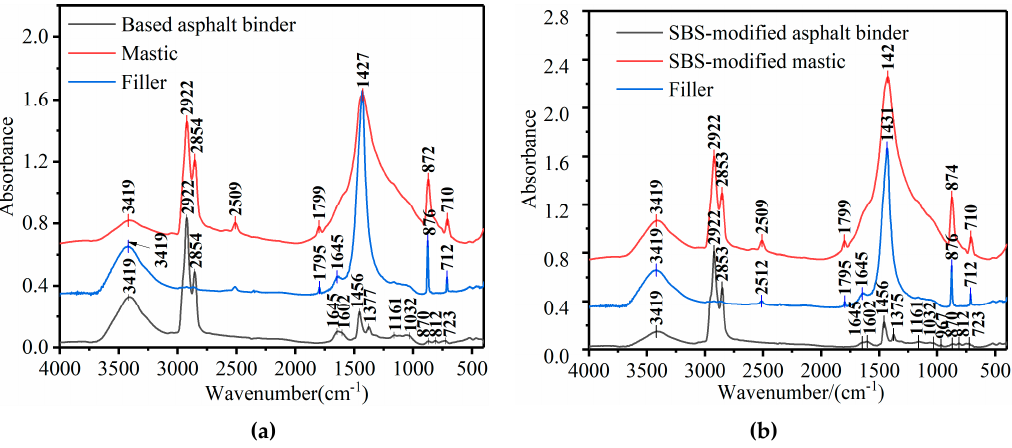
Figure 6. Spectra of asphalt binder, filler, and mastic. ( a ) Base mastic; ( b ) SBS-modified mastic.